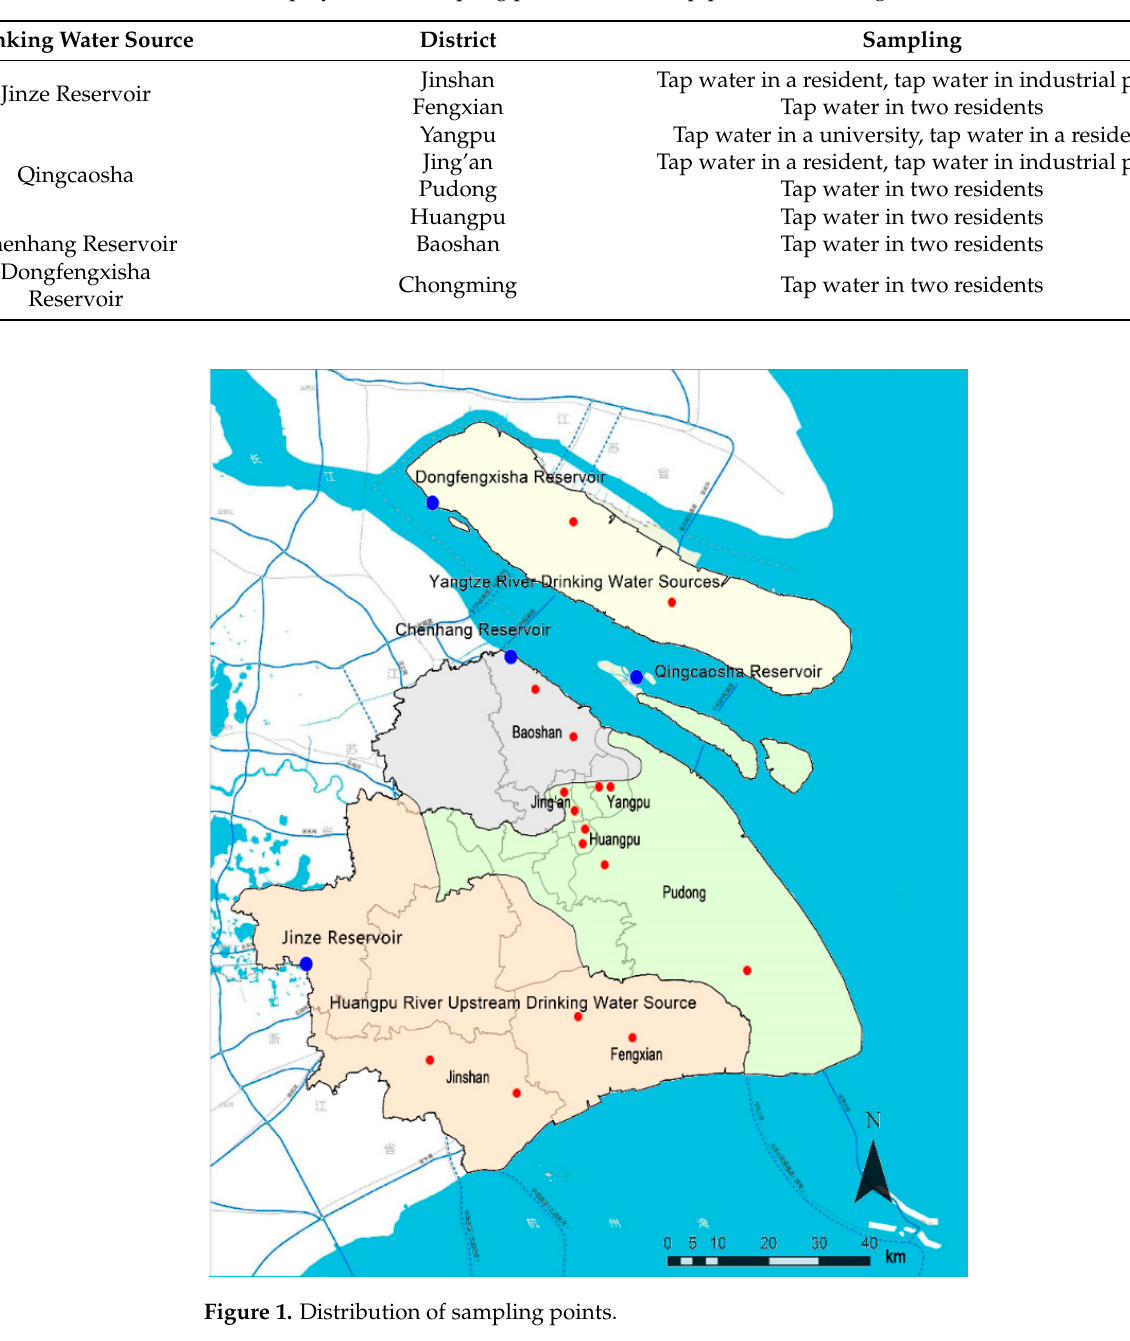
Table 1. The deployment of sampling points for end-of-pipe water in Shanghai.